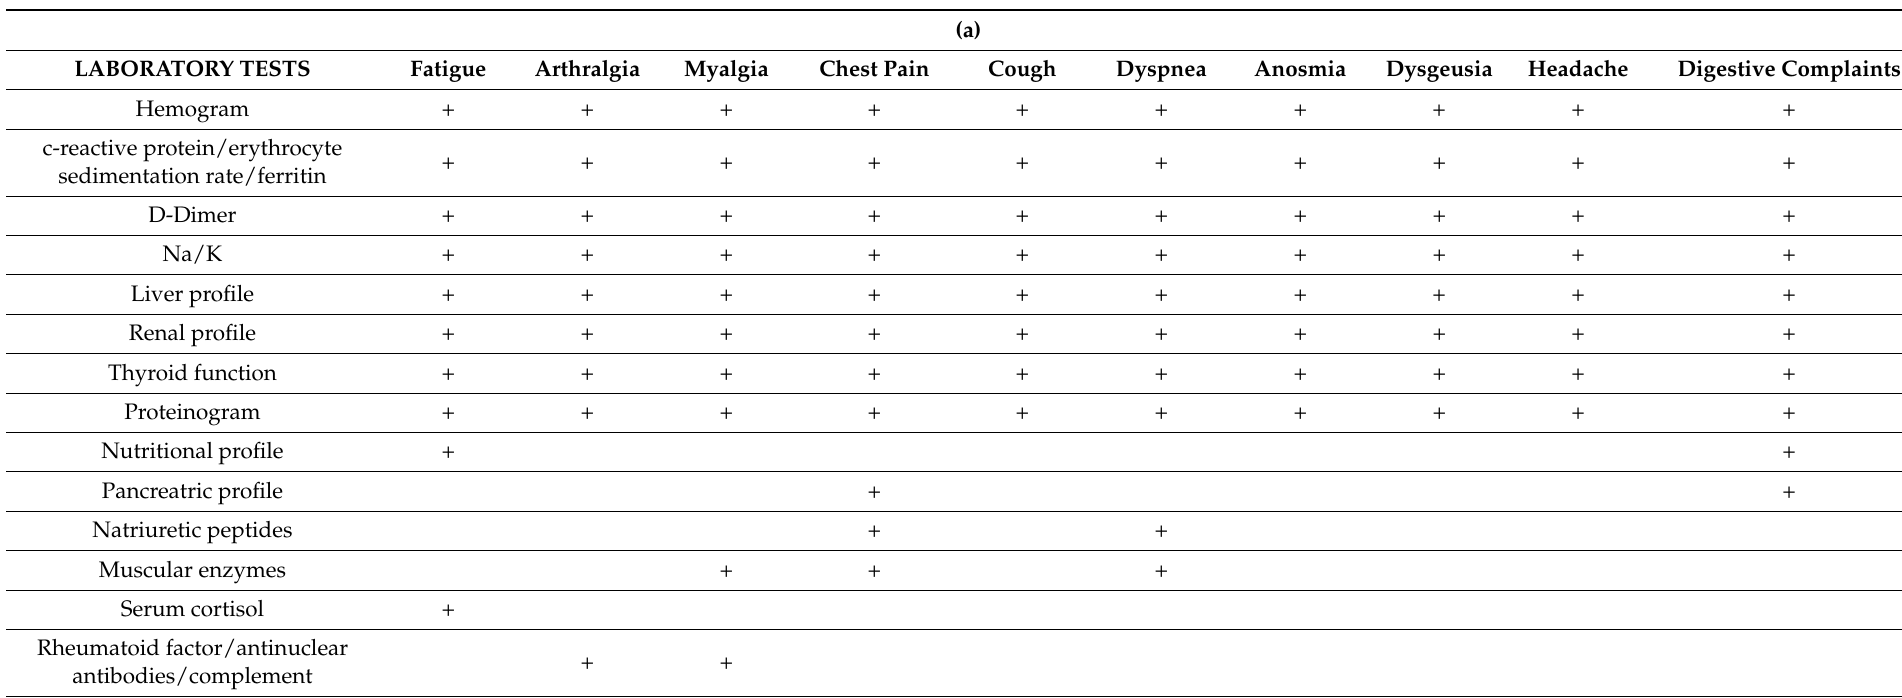
Table 2. Comprehensive evaluation of long COVID-19. ( a ). Laboratory tests. ( b ). Other diagnostic tests. Tests for each symptom are not mandatory but depend on individualized medical